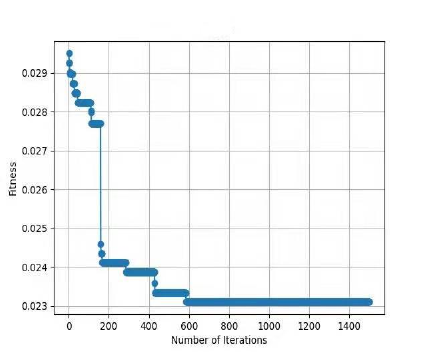
Figure 4. The fitness of EHHO.